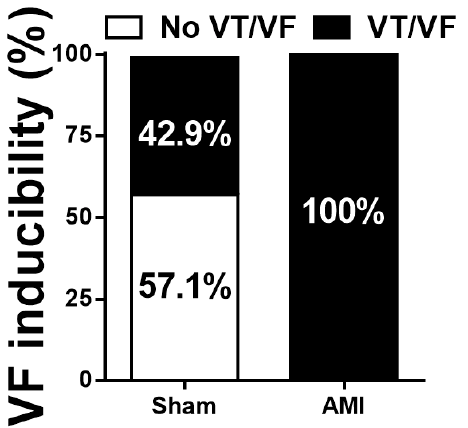
Figure 9. Ventricular tachycardia (VT) and/or ventricular fibrillation (VF) inducibility, and association between groups (sham, acute myocardial infarction) and VT/VF triggering (no VF, VT/VF).